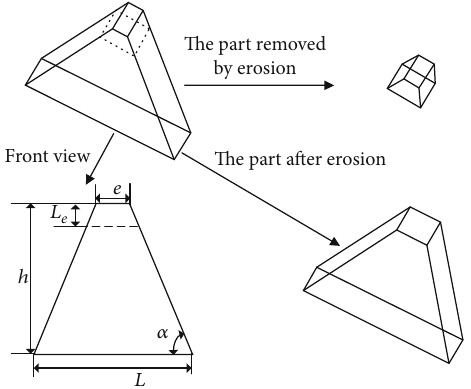
Figure 10: The relationship between k